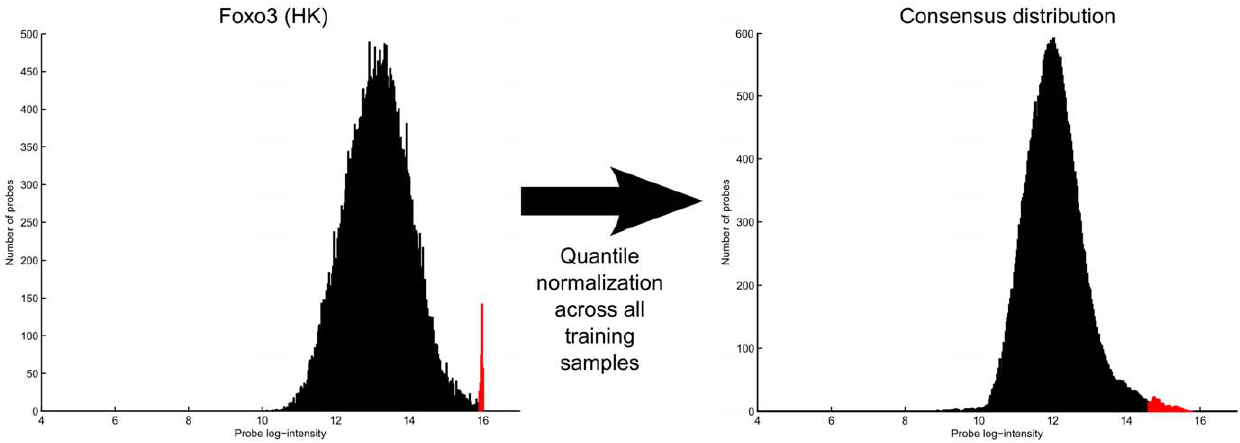
Figure 6. Quantile normalization recovers high intensity tails in saturated samples. The figure shows how the log-intensity histogram of the Foxo3 PBM sample is changed by quantile normalization. An example of how quantile normalization can recover the high intensity tails in saturated PBM samples. The saturated probe intensities (highlighted in red) are recovered by fitting them to the consensus distribution.